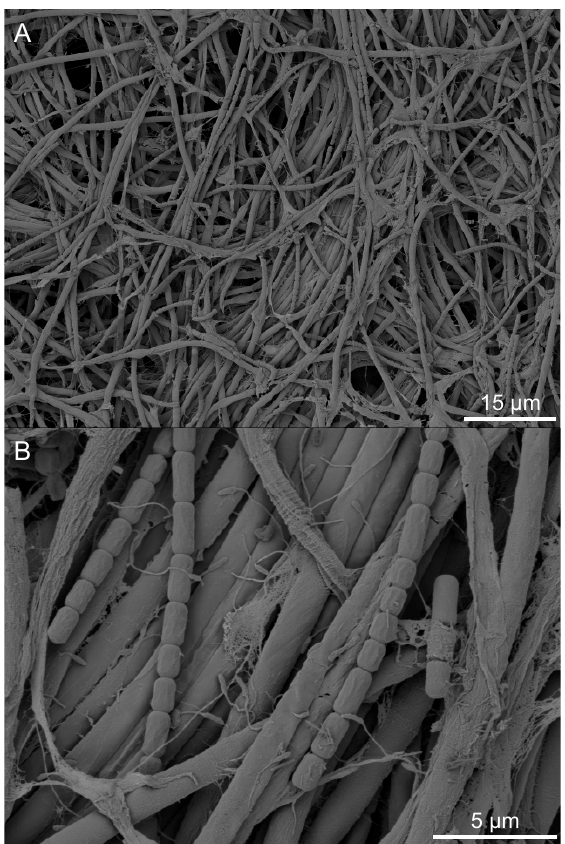
Figure 5. SE-SEM micrographs of the pyroaurite horizon found at 2-cm depth in the Bio-plot after 11 weeks showing ( A ) the relatively poor crystallinity of the pyroaurite indicated by subhedral platelets; and ( B ) the disarticulated chrysotile fibers found among the pyroaurite crystals. Secondary electron micrographs of the carbonate horizon found from 2–4 cm depth in the Bio-plot after 11 weeks showing ( C ) the extent of platy hydromagnesite mixed with ( D ) residual chrysotile fibers.